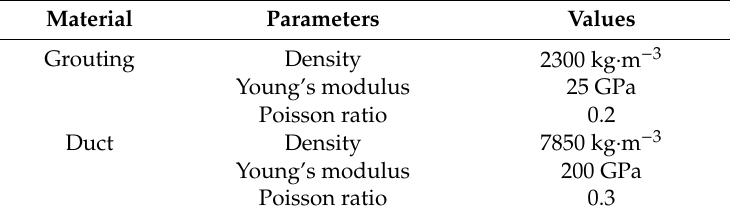
Figure 10. Finite element model of grouting compactness. Table 3. Material properties.